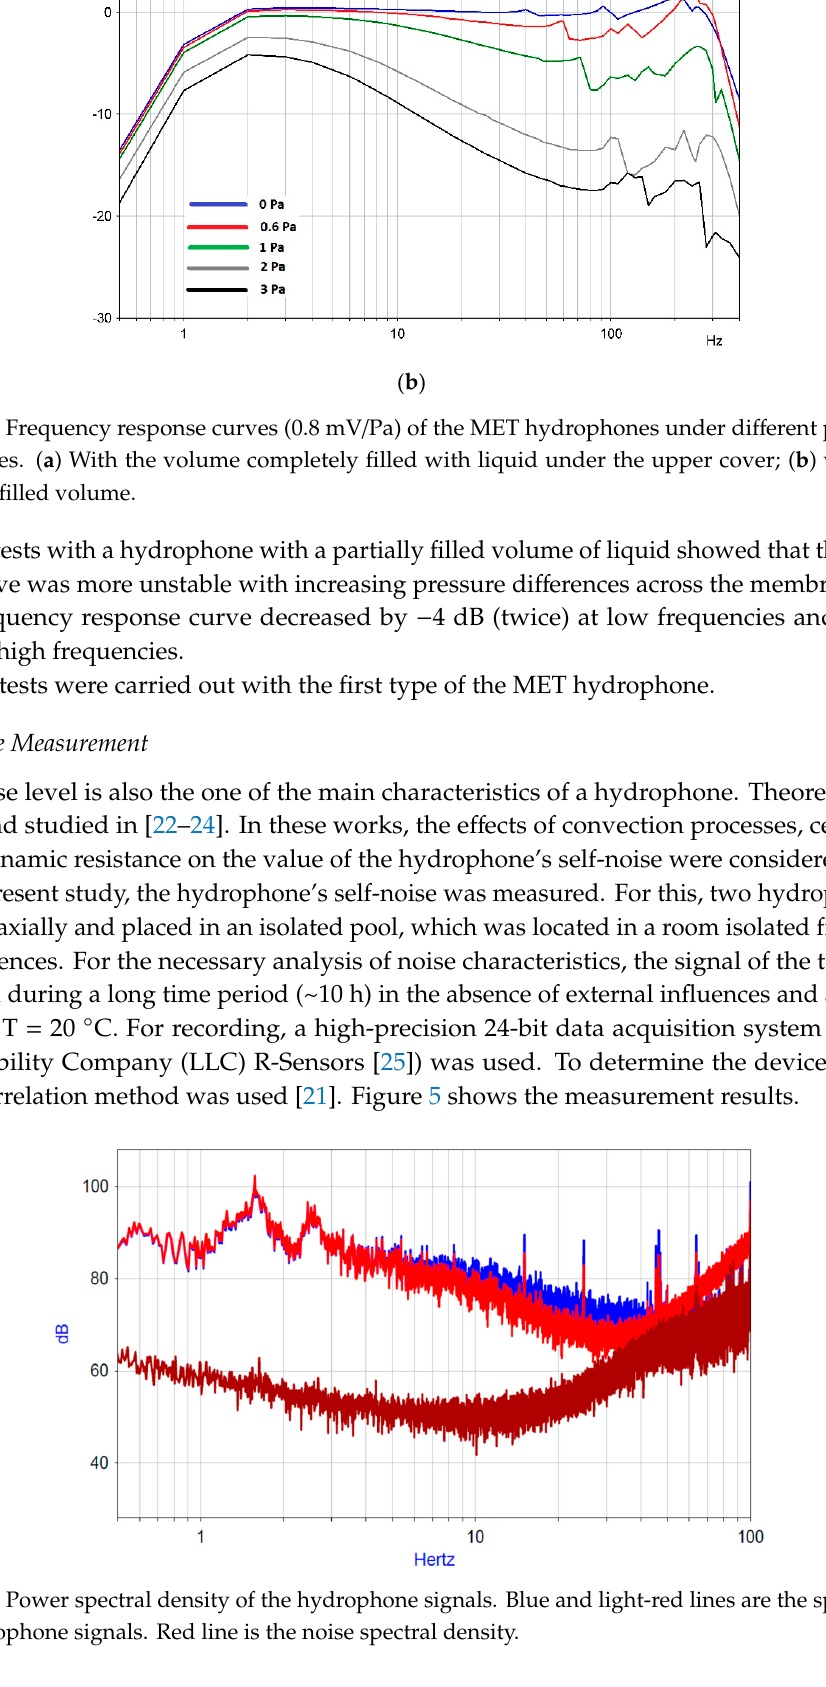
Figure 5. Power spectral density of the hydrophone signals. Blue and light-red lines are the spectra of the hydrophone signals. Red line is the noise spectral density.